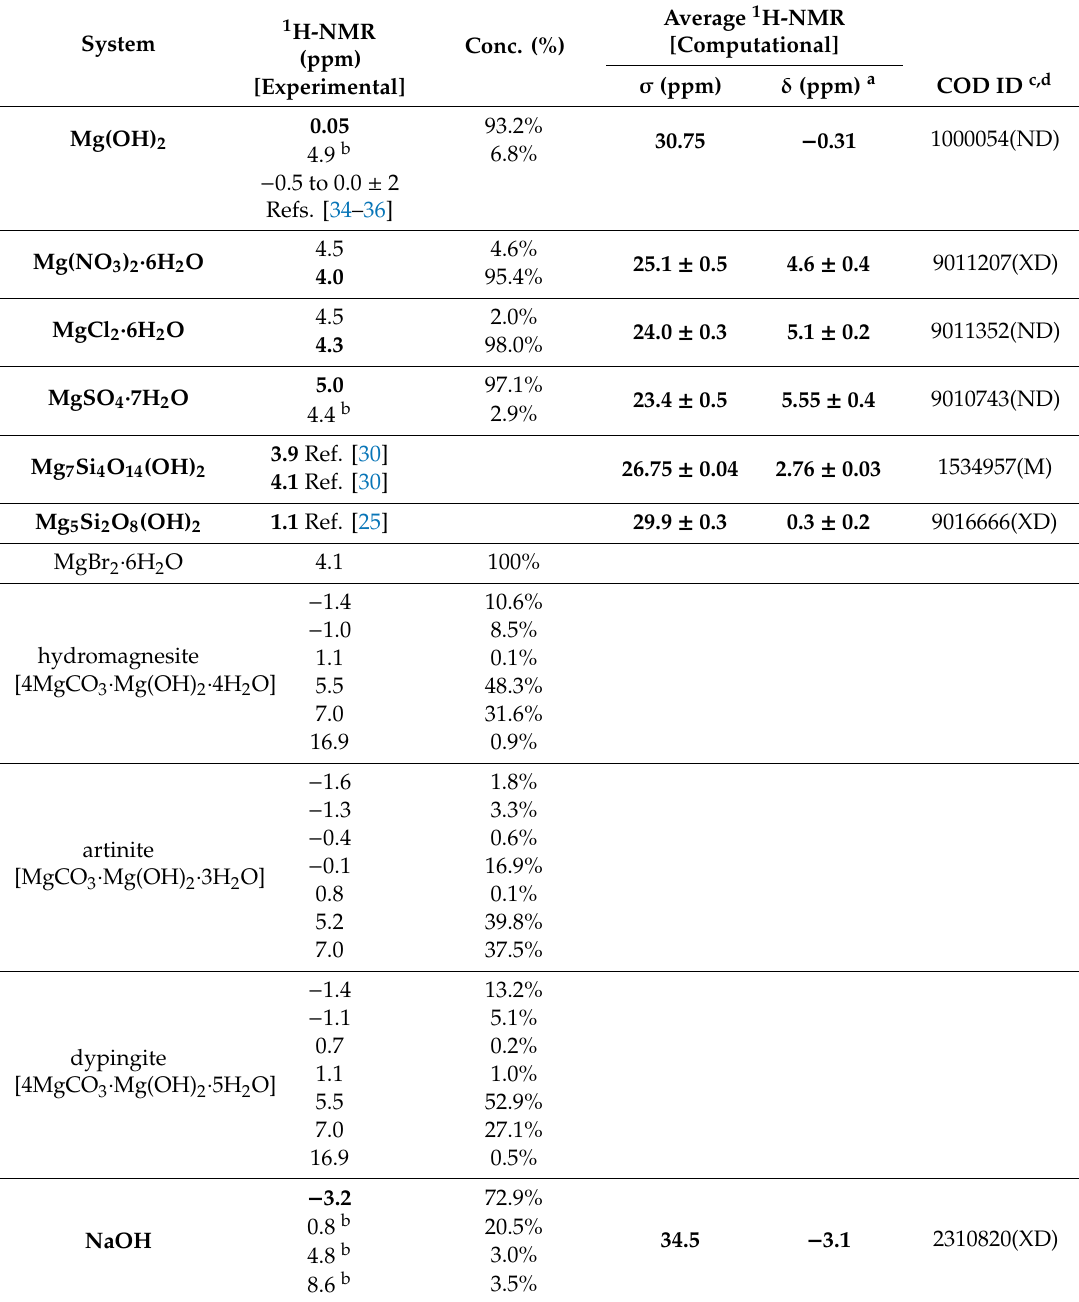
Table 1. 1 H-NMR chemical shifts ( δ ), relative concentration (%), and computational chemical shielding ( σ ) of proton environments in select Mg-containing materials. Reference compounds shown in